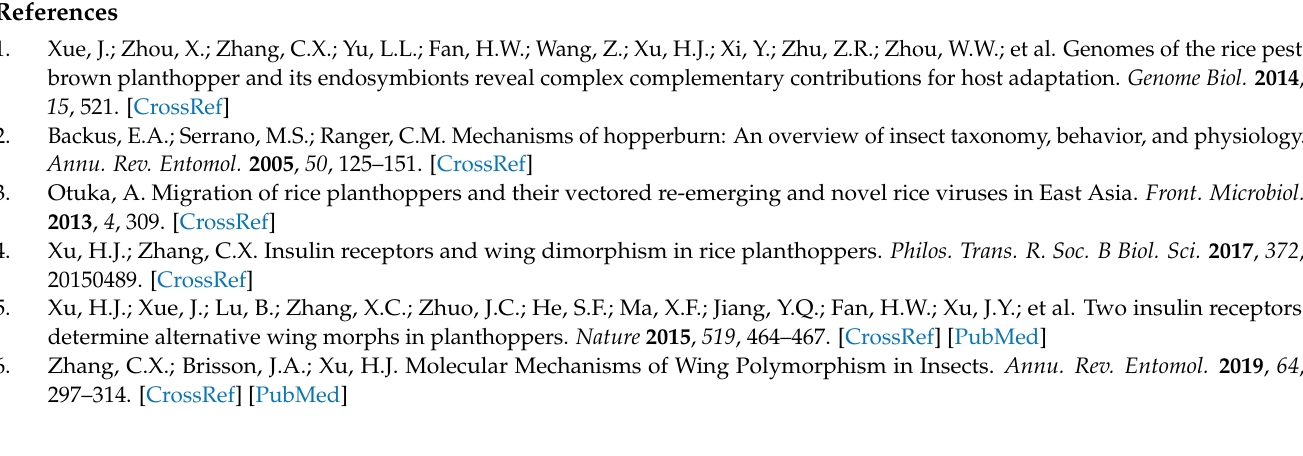
S3: KEGG enrichment of differentially expressed genes in forewing and hindwing buds at 24, 36, and 48 hAE. Supplementary Table S4: Differentially expressed genes of GO classification in hindwing at 24 hAE. Supplementary Table S5: Differentially expressed genes of GO classification in forewing at 36 hAE. Supplementary Table S6: Differentially expressed genes of GO classification in hindwing at 36 hAE. Supplementary Table S7: Differentially expressed genes of GO classification in forewing at 48 hAE. Supplementary Table S8: Differentially expressed genes of GO classification in hindwing at 48 hAE. Supplementary Table S9: Differentially expressed genes associated with cell cycle and DNA